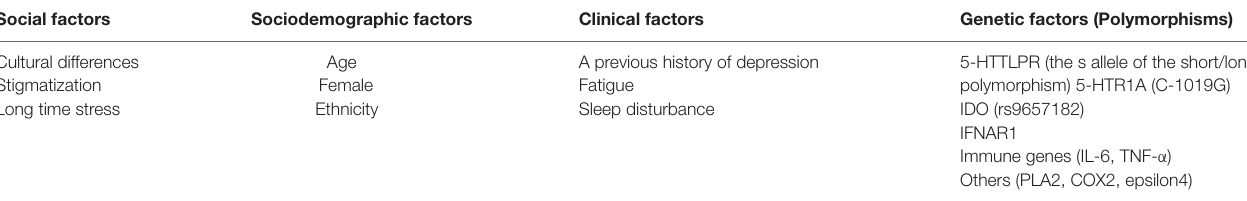
TABLE 3 | Potential risk factors of depression in patients with